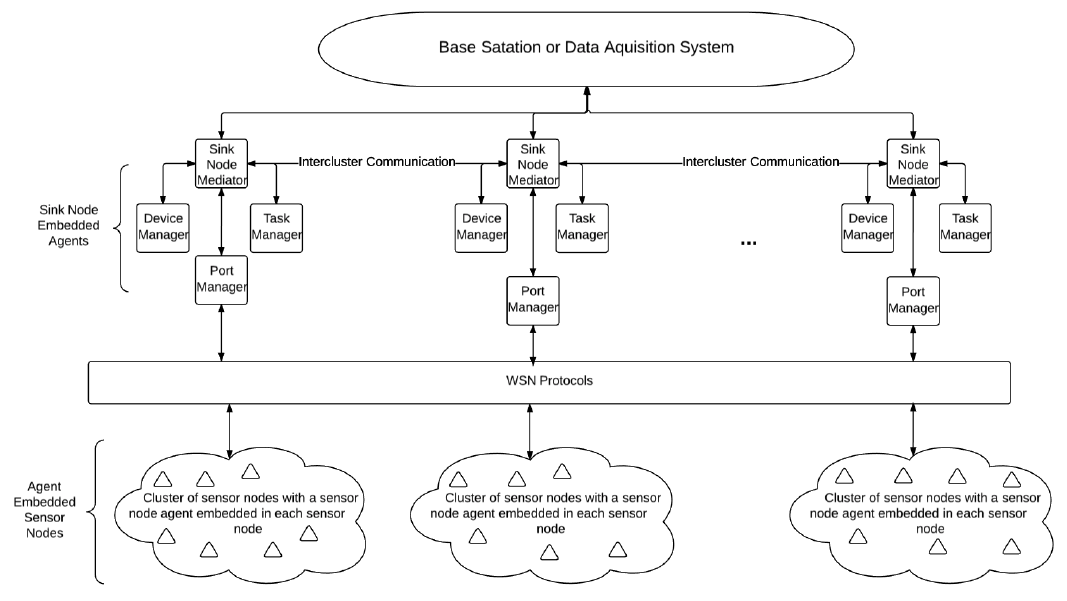
Figure 5. Wireless sensor network